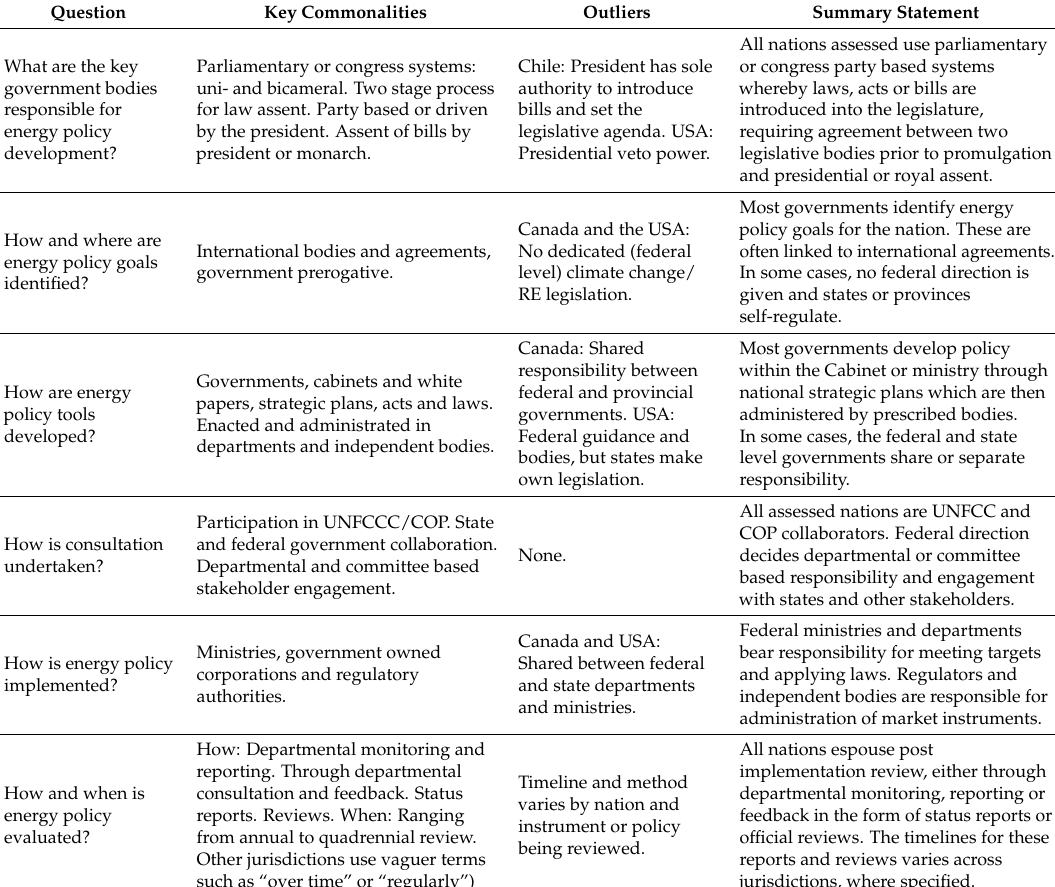
Table 7. Governance and policy making QCA data summary.